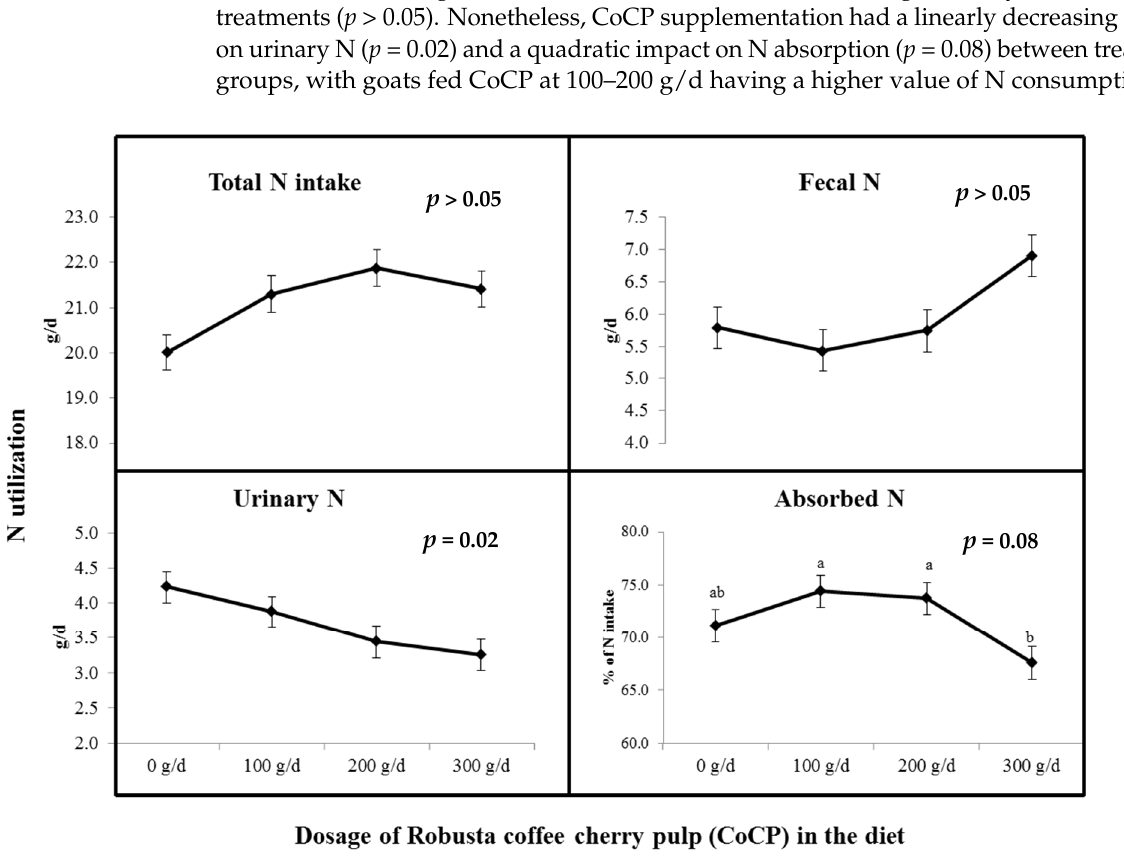
Figure 2. The figure plots the average outcomes of supplement levels (g/d) of CoCP on N balance in goats. a,b Different superscripts displayed significantly different mean values ( p <